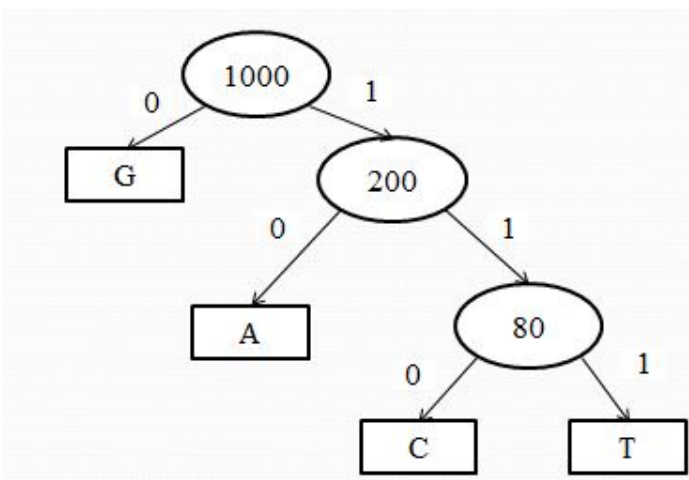
Figure 5: Generated tree for Example 3.